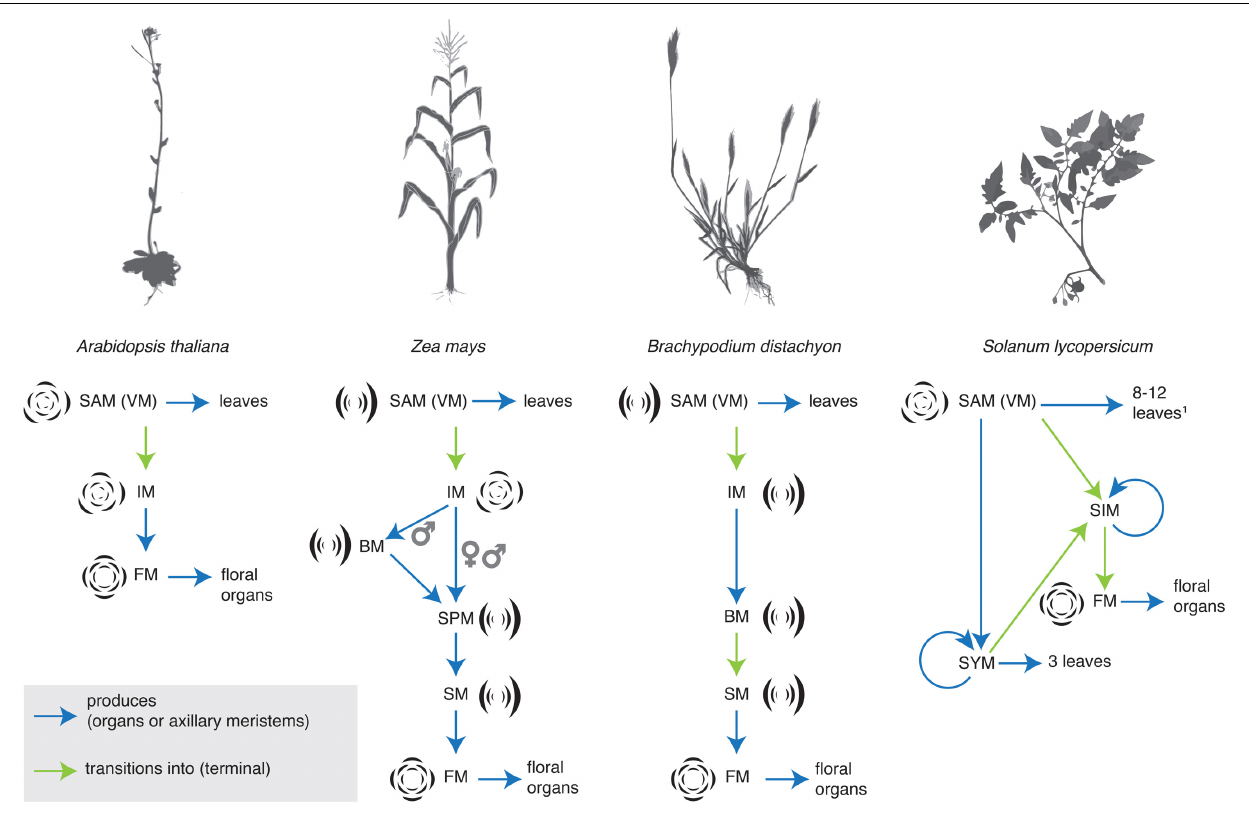
FIGURE 1 | Sterotypical shifts in inflorescence identity in Arabidopsis thaliana , maize, the Pooid grass Brachypodium distachyon , and tomato ( Solanum lycopersicum ). BM, branch meristem; FM, floral meristem; IM, inflorescence meristem;